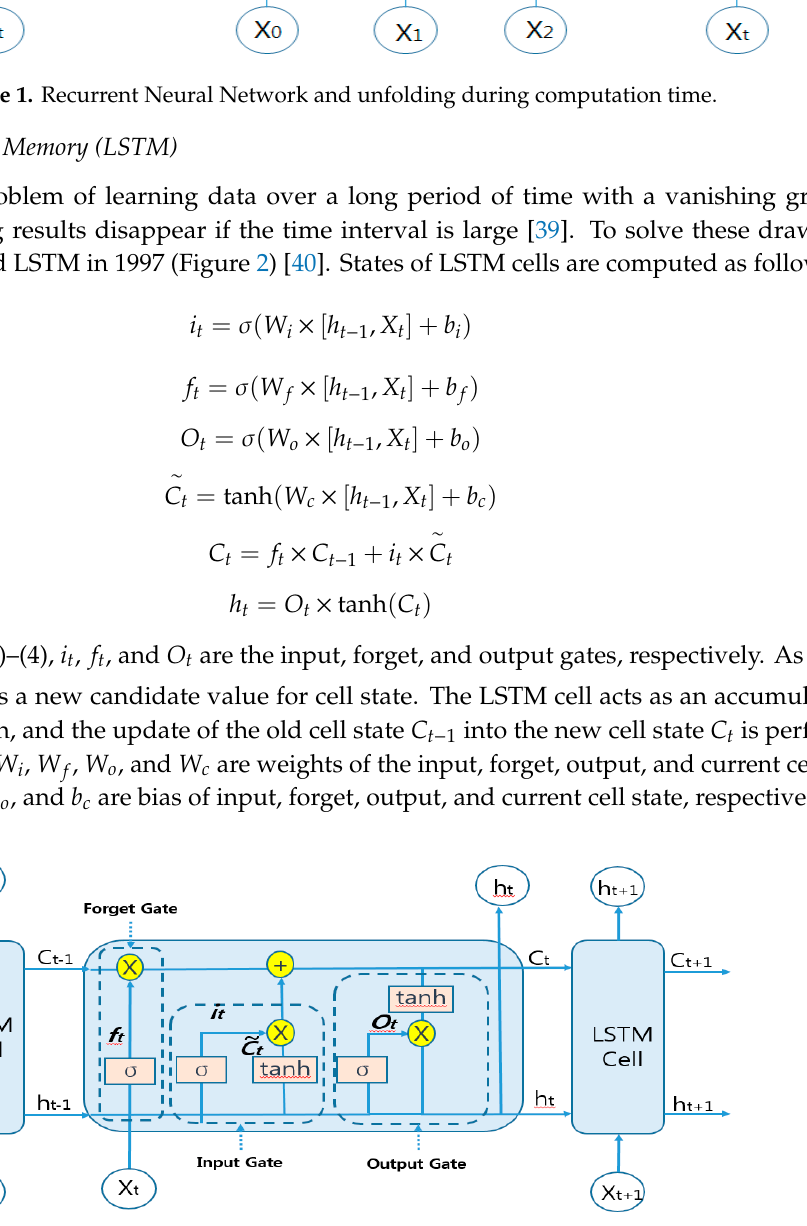
Figure 2. Structure of long short-term memory.